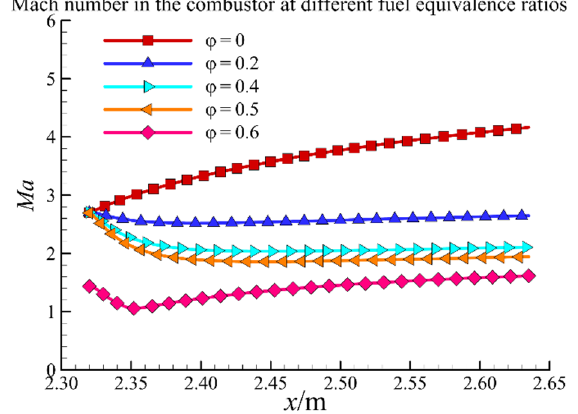
Figure 9. Mach number along the combustor at fuel equivalence ratios in the range of 0 to 0.6.